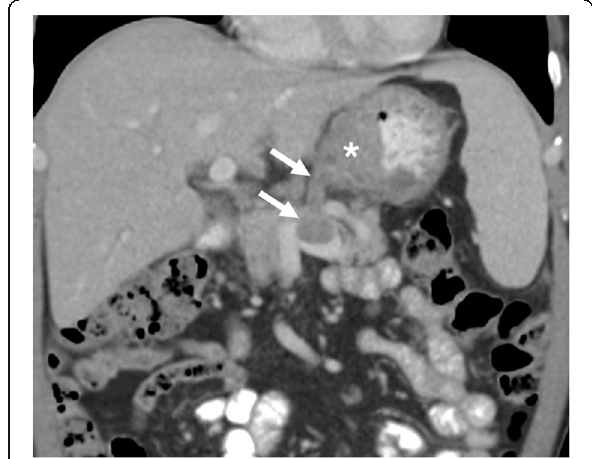
Fig. 7 A 45-year-old male with newly diagnosed gastric cancer. Coronally reformatted postcontrast CT image shows the primary tumor in the gastric wall (asterisk) with tumor thrombus (arrows) extending into the splenic